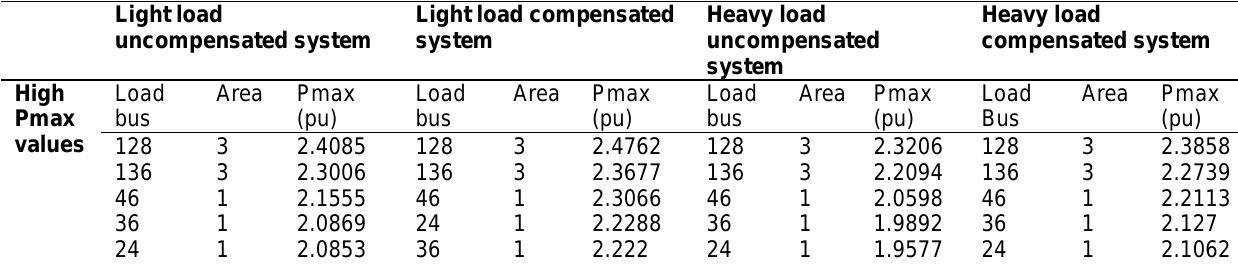
Light load uncompensated